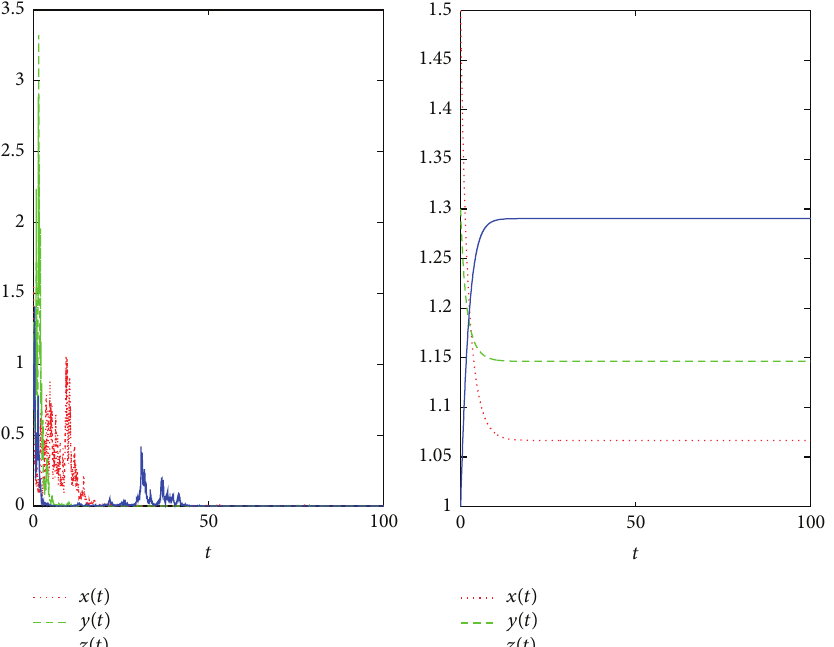
d 𝑥 (𝑡) = 𝑥 (0.45 + + 1.2𝑥 d 𝐵